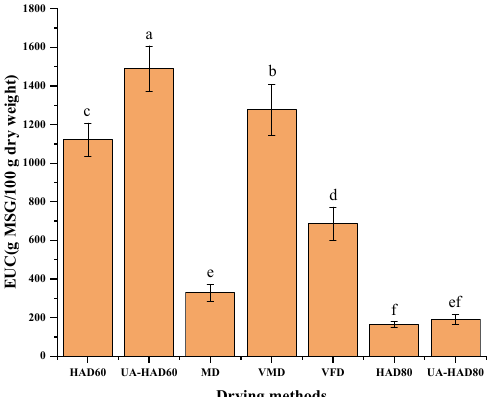
Figure 4. The changes of equivalent umami concentration (EUC) of O. raphanipes subjected to different drying methods. Different letters indicate significant difference ( p < 0.05); Same letter means no significant difference ( p > 0.05). HAD60—60 °C hot air drying, HAD80—80 °C hot air drying, UA- HAD60—ultrasonic-assisted 60 °C hot air drying, UA-HAD80—ultrasonic-assisted 80 °C hot air